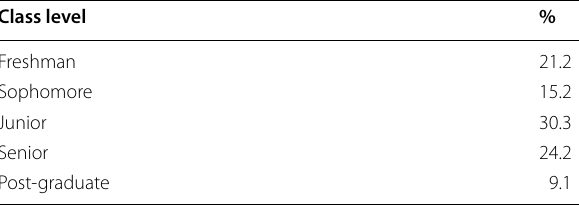
Table 1 Student level in the undergraduate/graduate